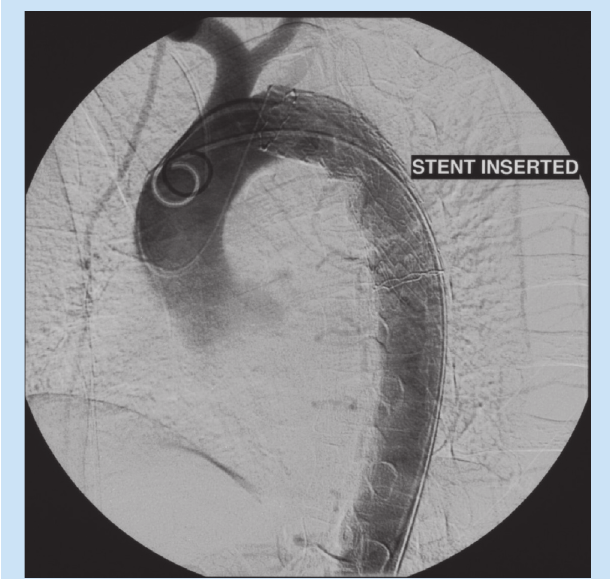
Fig. 4. Digital subtraction angiogram obtained after endovascular stent graft deployment, demonstrating complete exclusion of the pseudo- aneurysm and occlusion of the origin of the LSA.